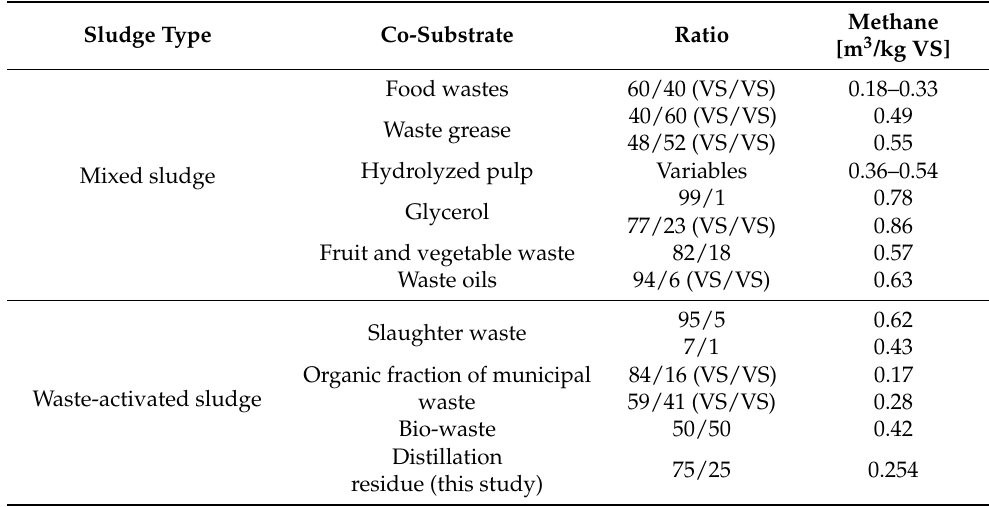
Table 6. Methane co-fermentation of sludge from wastewater treatment plants with wastes from various industries and trades